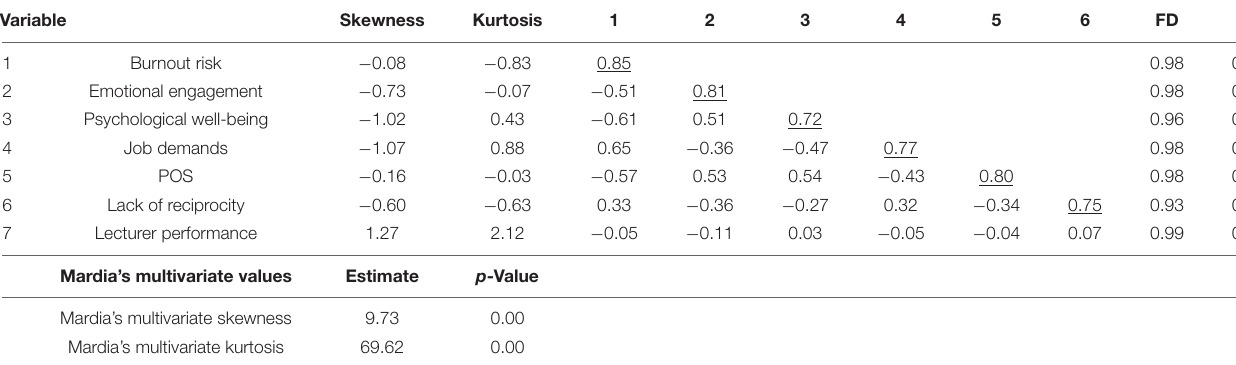
TABLE 1 | Descriptive statistics, correlations, skewness/kurtosis, and factor determinacy.